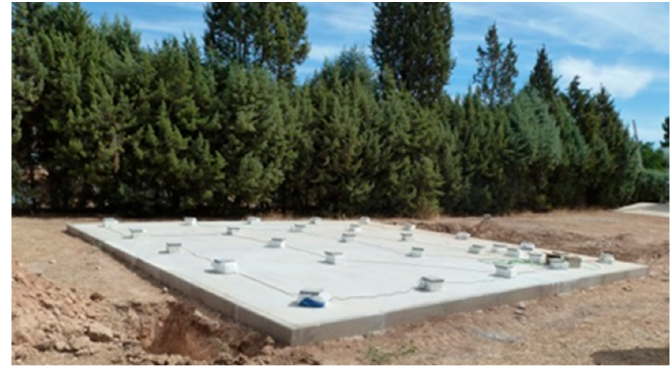
Figure 14. Experimental slab in Arganda del Rey (Madrid)—Spain.